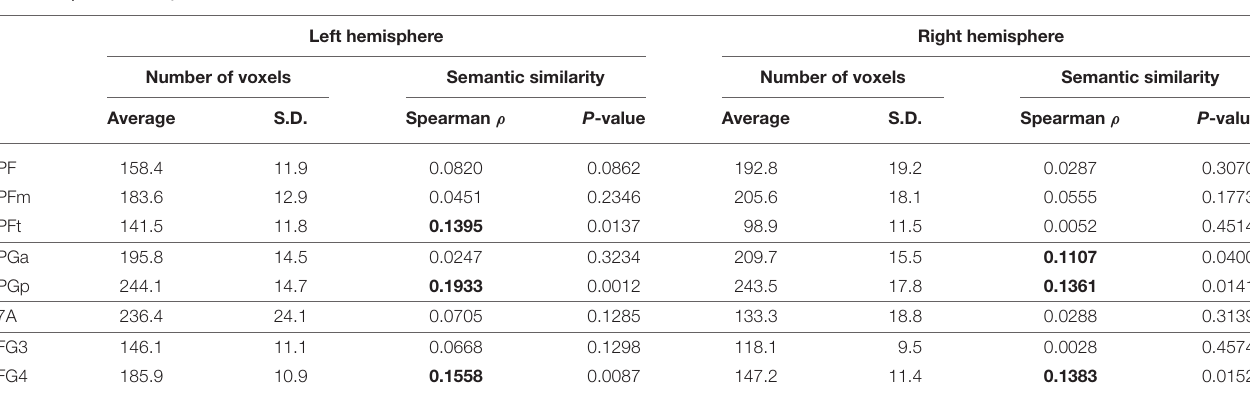
TABLE 7 | Control analysis for VOI size.